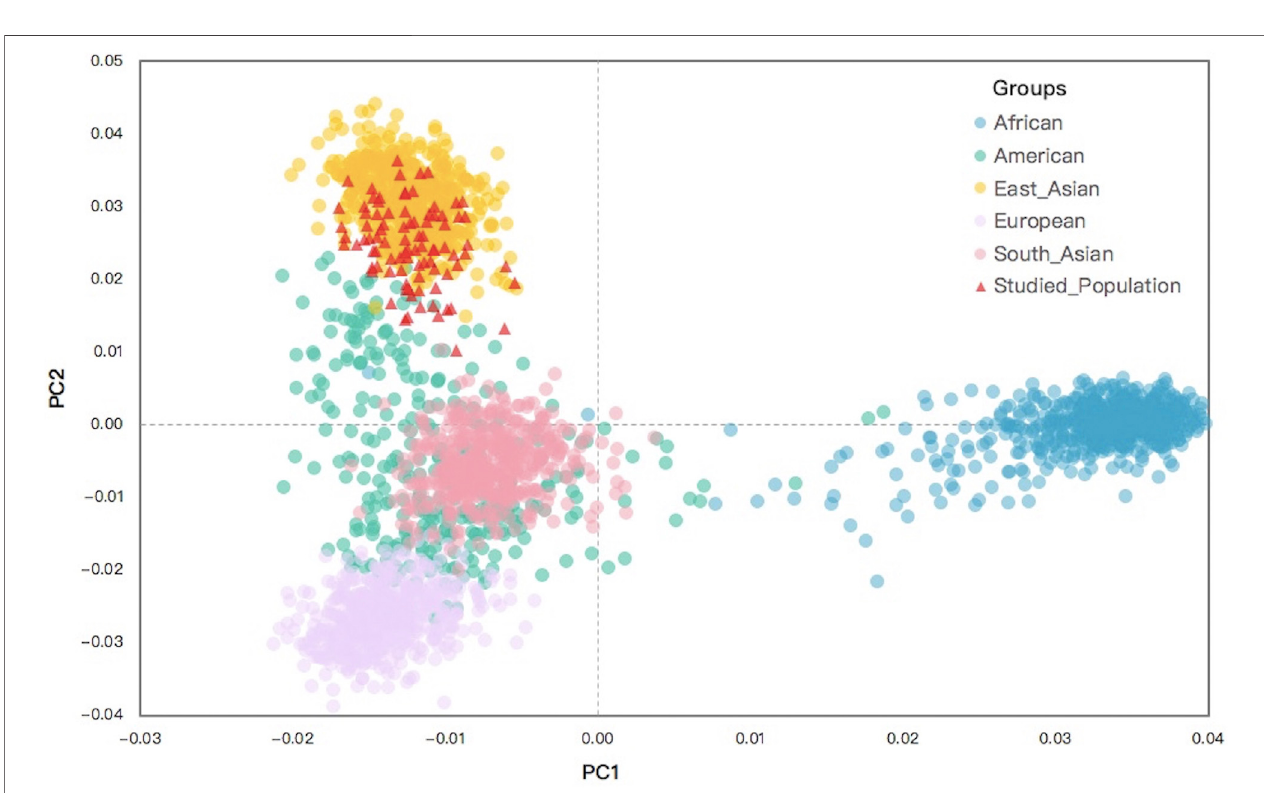
FIGURE 7 | A PCA plot for individuals from the Northwest Hui group and the 26 reference populations based on the raw data for the same 55 AISNPs. PCA, principal component analysis; AISNPs, ancestry-informative single-nucleotide polymorphisms.